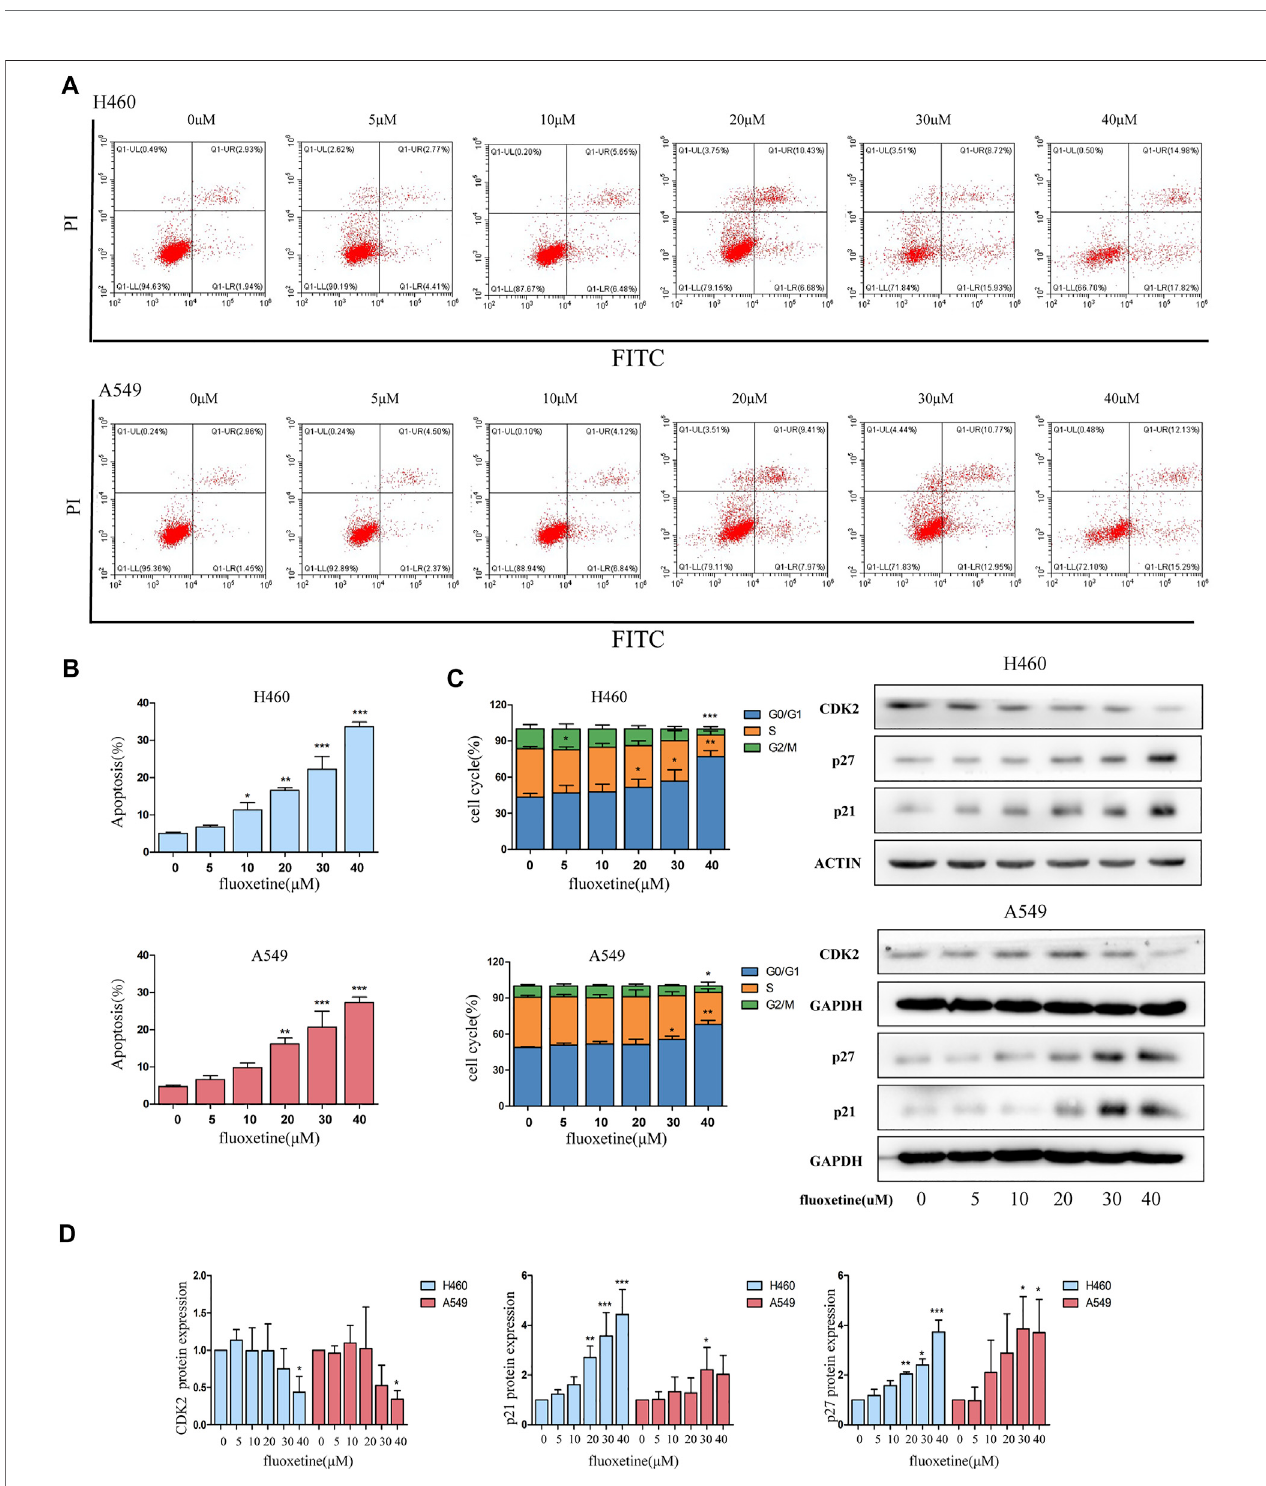
FIGURE 2 | Fluoxetine arrested cell cycle at G0/G1. (A) Cells were treated with fl uoxetine (0 – 40 μ M) for 24 h, performed PI/FITC staining, and analyzed with fl ow cytometry. (B) Percentage ofapoptosis cellswasanalyzed. (C) Distribution ofthecellcyclewasanalyzed byModFit LT5.0software and theresultoftheWesternblotof CDK2, p27, and p21. The images were collected from different parts of the same gel. (D) Quantitative analysis of optical band densitometry. Data are presented as mean ± SD; * p < 0.05, ** p < 0.01, *** p < 0.001.